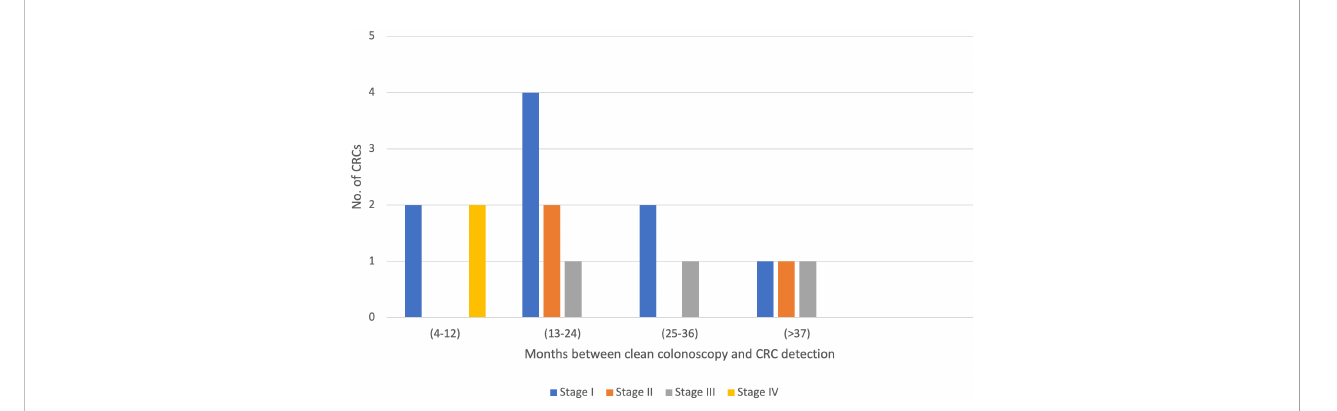
FIGURE 1 Colorectal cancer (CRC) detection after index. Intervals between clean colonoscopies and CRC detection of TNM-classi fi ed CRCs detected after